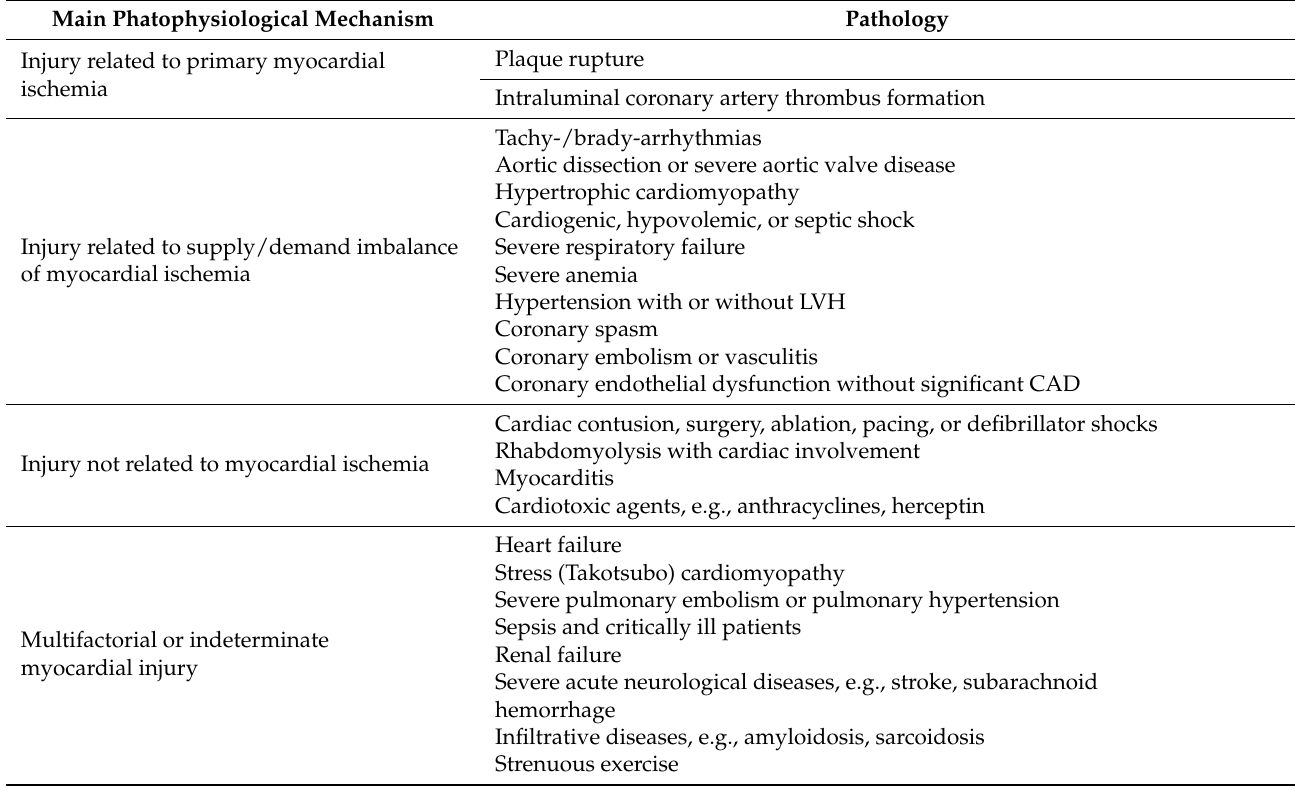
Table 1. Causes of troponin elevation. Modified from Thygesen et al.